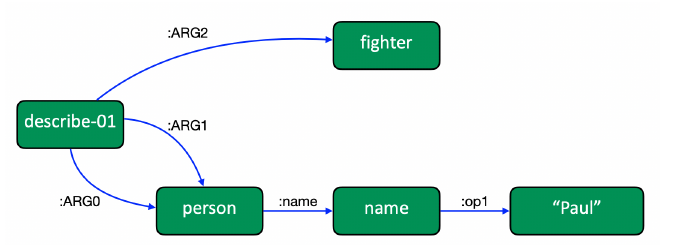
Figure 12. Example of AMR graph obtained from the sentence: “Paul’s description of himself: a fighter”. Taken from [117].